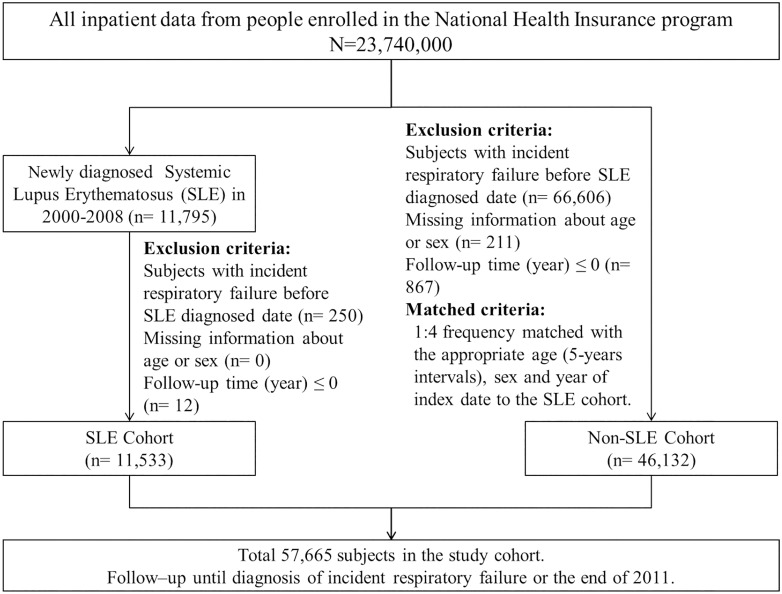
Flowchart presenting the process of selecting the study subjects.